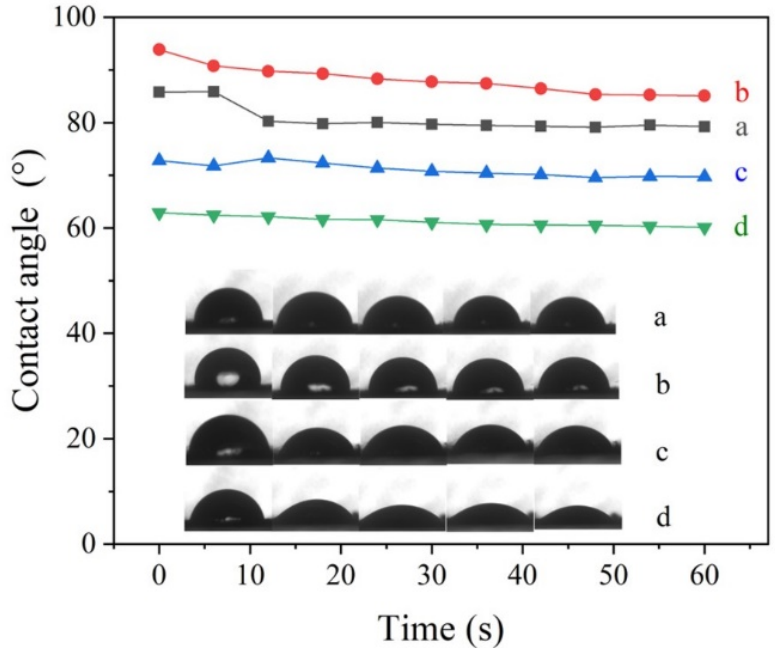
Figure 5. Contact angle values and images of ( a ) deionized water, ( b ) Pro TC, ( c ) BMMs and ( d ) Pro@BMMs-SS-Py/ β -CD NPs on tomato leaves.